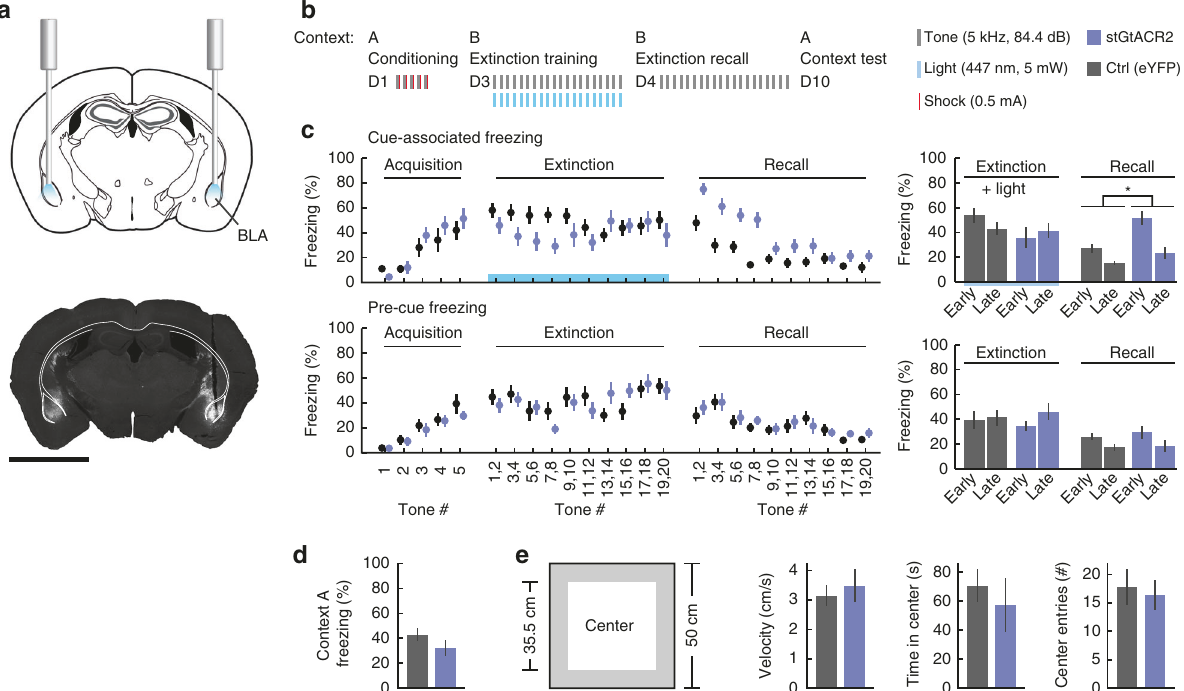
Fig. 8 Silencing of cue-associated BLA activity using stGtACR2 suppresses extinction of cued freezing. a Schematic diagram depicting the location of AAV injections and fi ber implants in the BLA of stGtACR2 mice ( n = 8) and eYFP controls ( n = 8; Schematic based on 68 ). Scale bar, 2 mm. b stGtACR2- expressing and control (eYFP) mice were subjected to auditory fear conditioning (day 1, conditioning), extinction training (day 3, early and late extinction) and extinction recall (day 4, early and late recall). During auditory fear conditioning mice were subjected to fi ve tone (CS)-shock (US) presentations in context A. On day 3 twenty 30 s tone (CS) presentations were paired with light (30 s constant 447 nm light at 5 mW at the fi ber tip) in context B. On day 4 extinction recall was tested by twenty 30 s tone presentations in context B. c Percentage of freezing during presentation of the CS (top row) and the 30